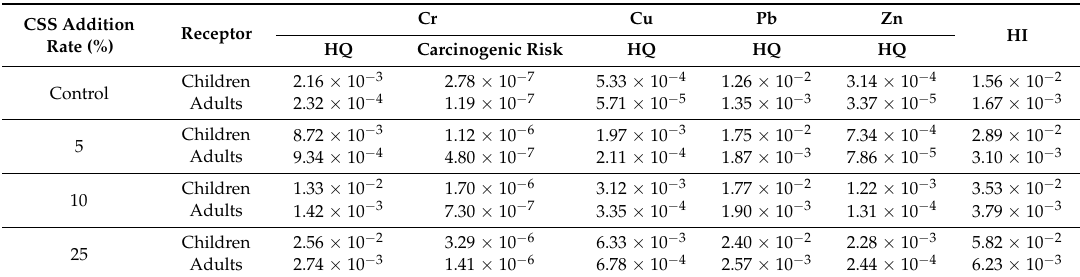
Table 5. Health risks from exposure to heavy metals in the control and amended soil via incidental ingestion. HQ: hazard quotient. HI: hazard